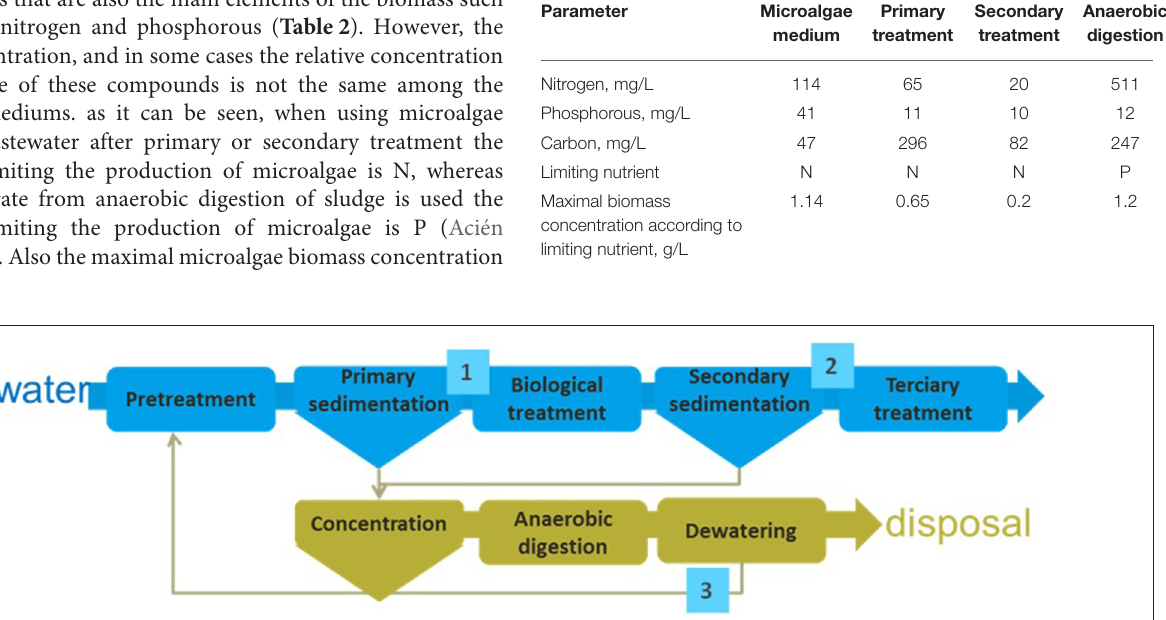
FIGURE 4 | Scheme of a conventional wastewater treatment process. Composition of wastewater at different points inside the wastewater treatment plant is included in Table 2 .